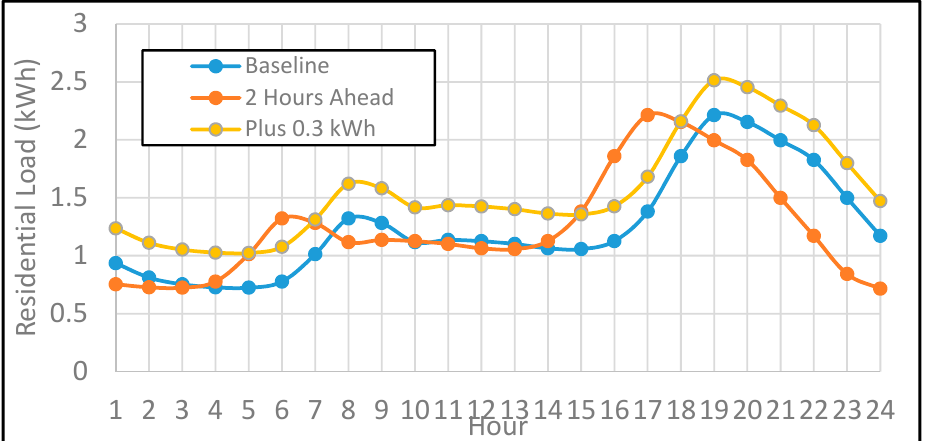
Figure 3. Illustration of horizontal and vertical load variation simulation.